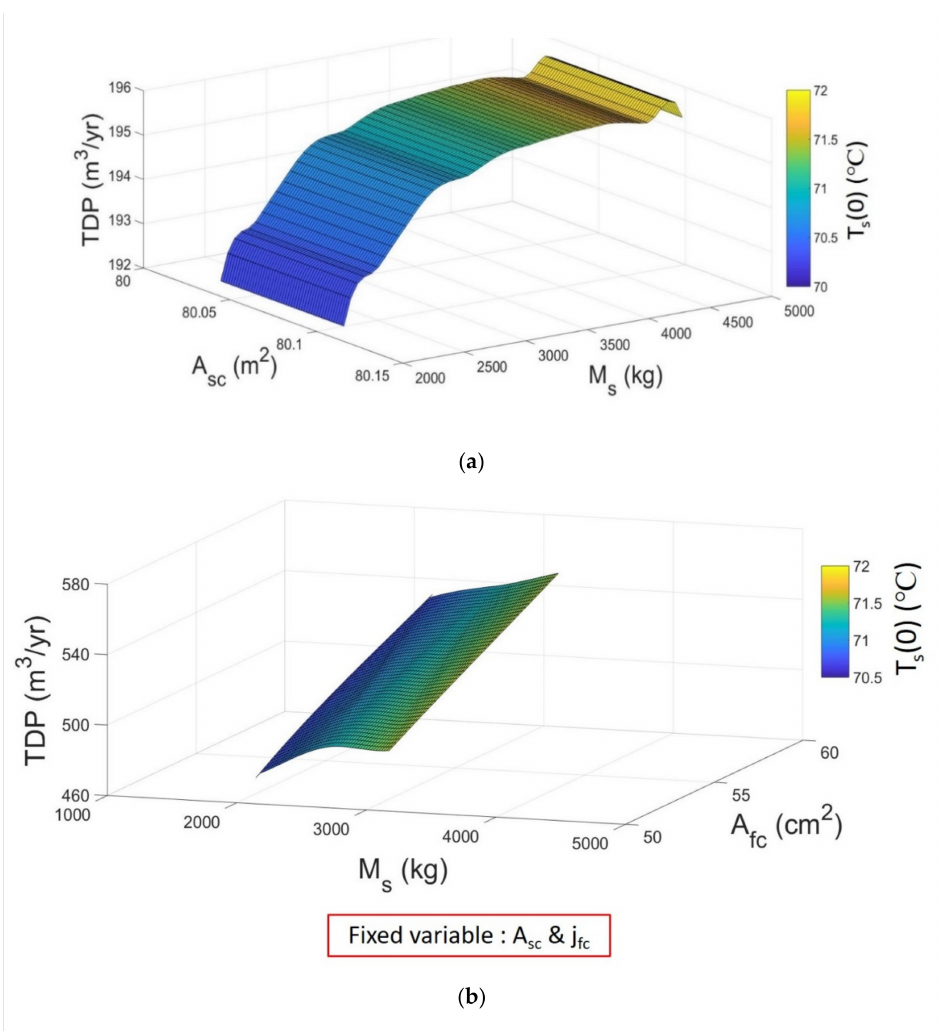
Figure 11. The TDP for the optimization variables of ( a ) the solar-heated membrane distillation system and ( b ) the PEMFC coupled solar-heated membrane distillation system (A sc and j fc are fixed) with